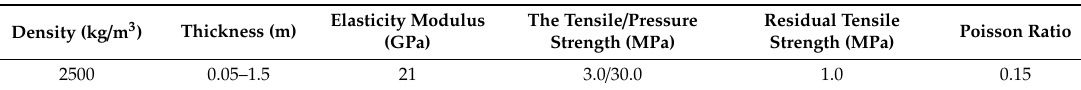
Table 4. The parameters of